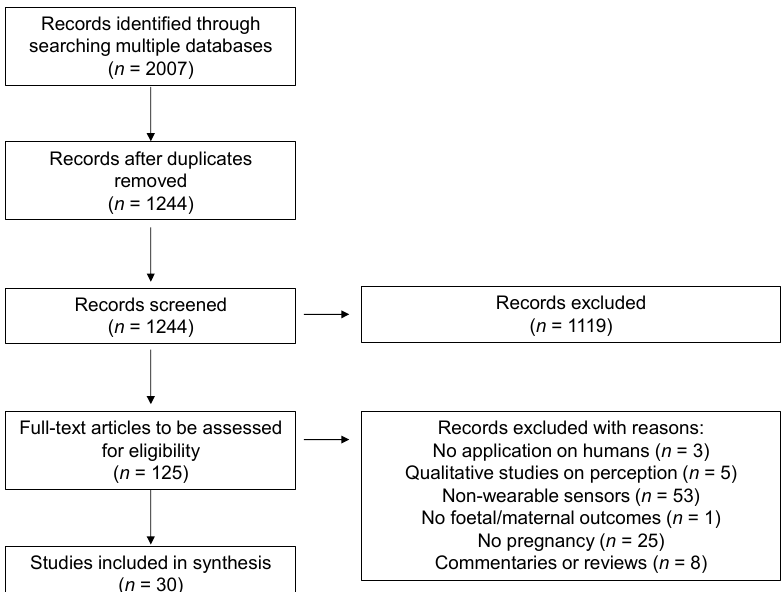
Figure 1. Selection of studies included in the scoping review.